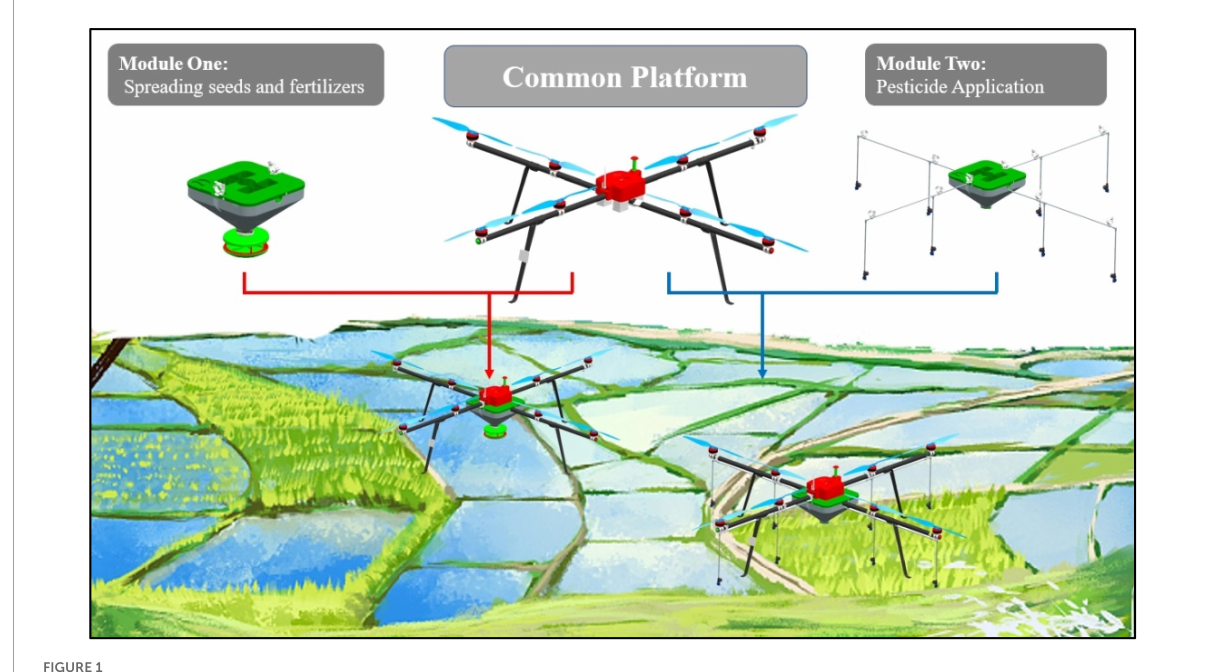
FIGURE1 mUAV total design